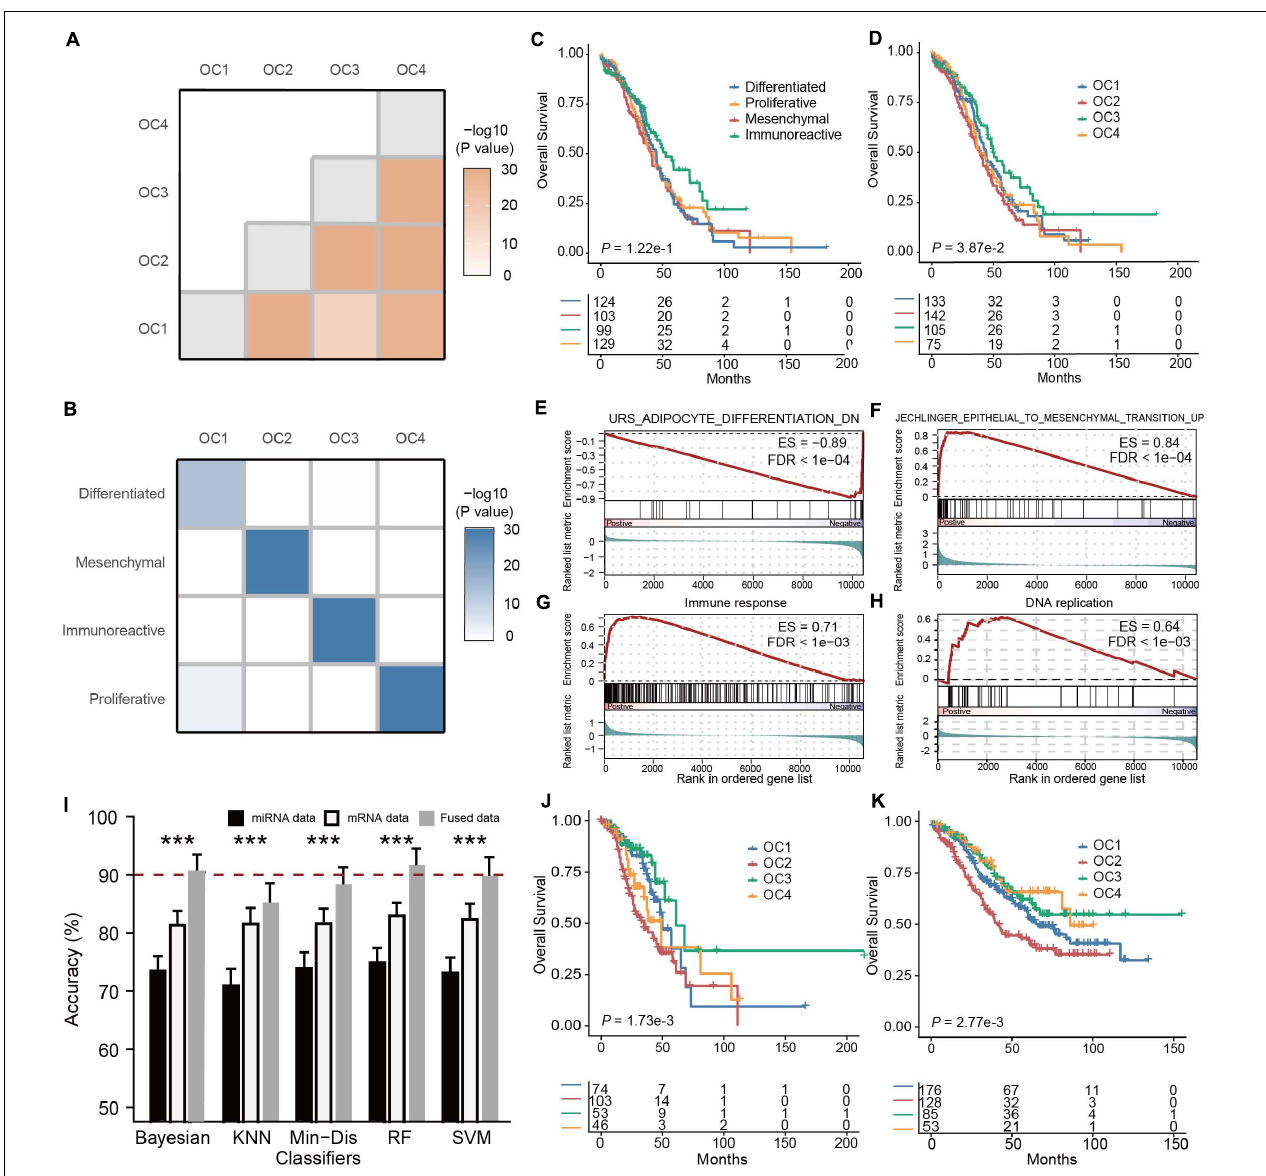
FIGURE 2 | Multi-omics subtyping of ovarian cancer using sparse canonical correlation analysis for cancer classification (SCCA-CC). (A) A heatmap showing the statistical significance of the differences between the identified OC subtypes. The color depth is proportionate to the -log 10 ( P- values) derived from SigClust. (B) A heatmap illustrating the association between ovarian cancer subtypes identified by SCCA-CC and the cancer genome atlas (TCGA). The heatmap is colored in proportion to the -log 10 ( P- values) derived from hypergeometric tests. (C,D) Kaplan-Meier plots showing the association of the subtypes identified by panel (C) TCGA and (D) SCCA-CC, respectively. P- values were calculated based on log–rank tests. (E–H) GSEA plots illustrating the representative pathways dysregulated in each molecular subtype identified by SCCA-CC. (I) A bar plot comparing the classification performance of the five classifiers on mRNA data, miRNA data, and the fused data, respectively. P- values were calculated based on Wilcoxon signed–rank tests. *** indicates P < 0.001. (J,K) Kaplan-Meier plots illustrating the association between the four subtypes identified by SCCA-CC with overall survival in this panel (J) the Tothill mRNA dataset and (K) the merged miRNA data. P- values were calculated based on log–rank